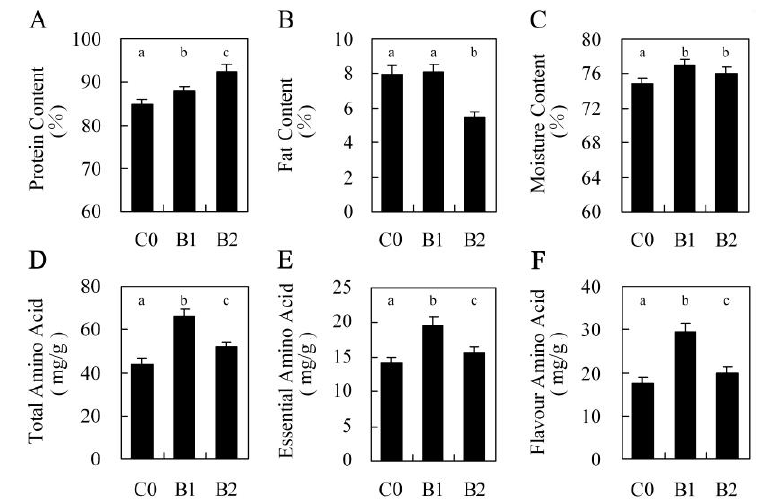
Figure 2. Comparison of moisture content, protein content, fat content and amino acid content between the control group and Bacillus licheniformis treated groups. C0: control B1: 1 ml Bacillus licheniformis supplemented treatment; B2: 2 ml Bacillus licheniformis supplemented treatment; %: the percent of dry